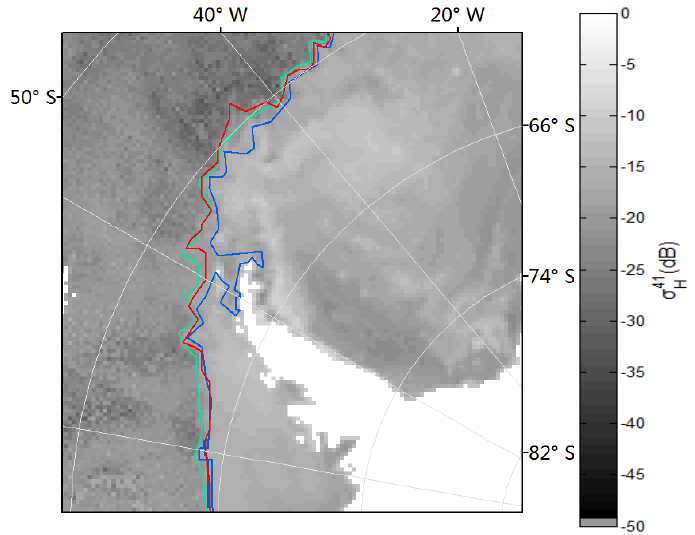
Figure 7. Sea ice edge comparisons in the Weddell Sea quadrant of Antarctica for 20 September 2013. The HY-2A/SCAT ice edge (red), SSMIS NASA Team 0% and 30% ice edges are superimposed on the image of σ 41 H